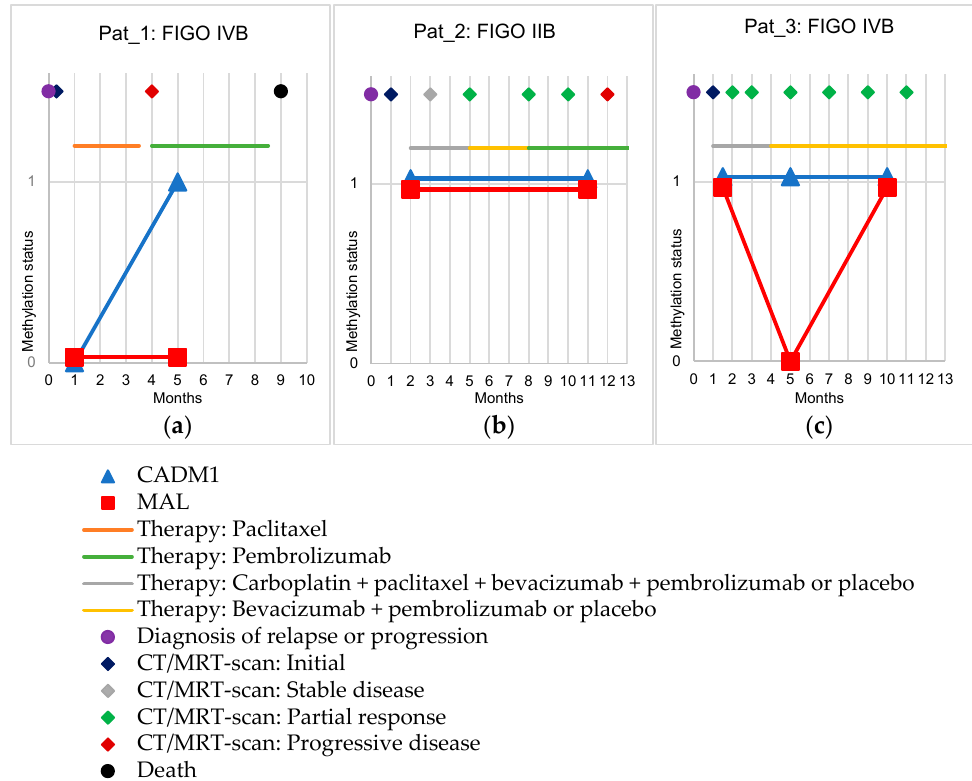
Figure 2. Methylation status of CADM1 and MAL (shown by the y -axis: 0 means negative, 1 means positive) in follow-up samples of three cervical cancer patients. The x -axis shows the time in months. In addition, therapies (lines) and disease progression (dots and diamonds) are shown. ( a ): Shows the follow-up of a patient in FIGO stage IVB with the progression of osseous metastases. ( b ): Shows the follow-up of a patient in FIGO stage IIB with a local relapse. ( c ): Shows the follow-up of a patient in FIGO stage IVB with a relapse in the form of newly appeared distant lymph node metastases.